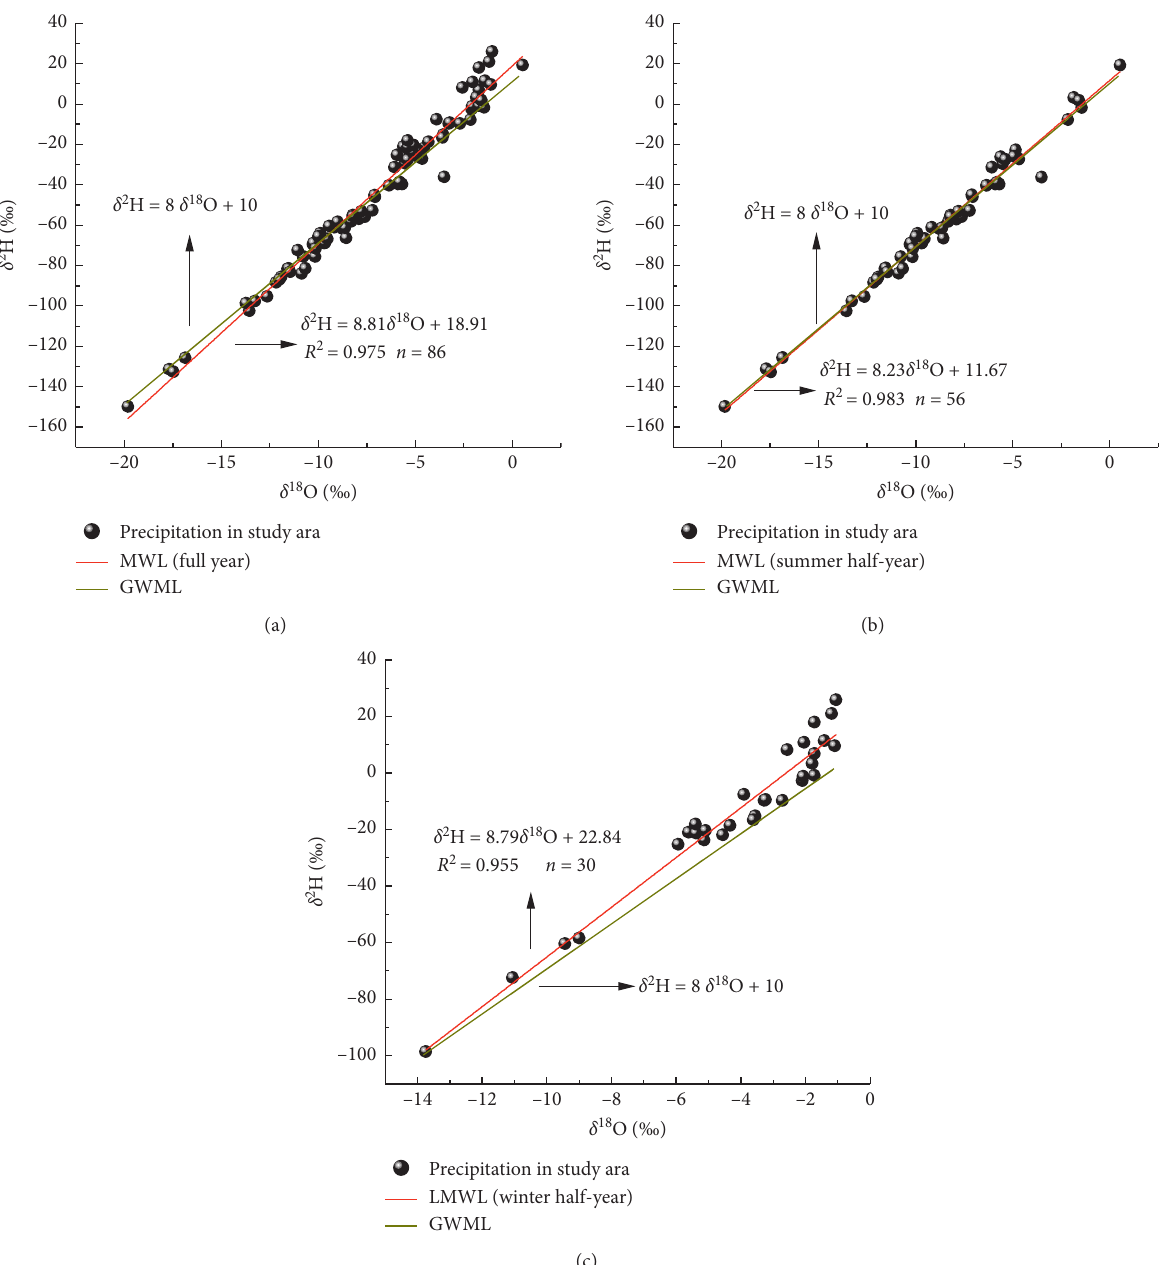
Figure 2: Equation of meteoric water line in the Guanling